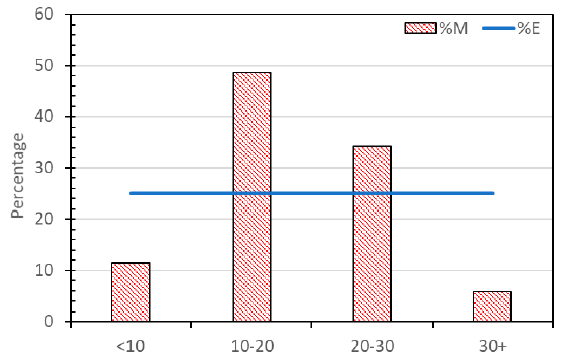
Figure 10. Results for the age of aircraft involved in aircraft maintenance related accidents.